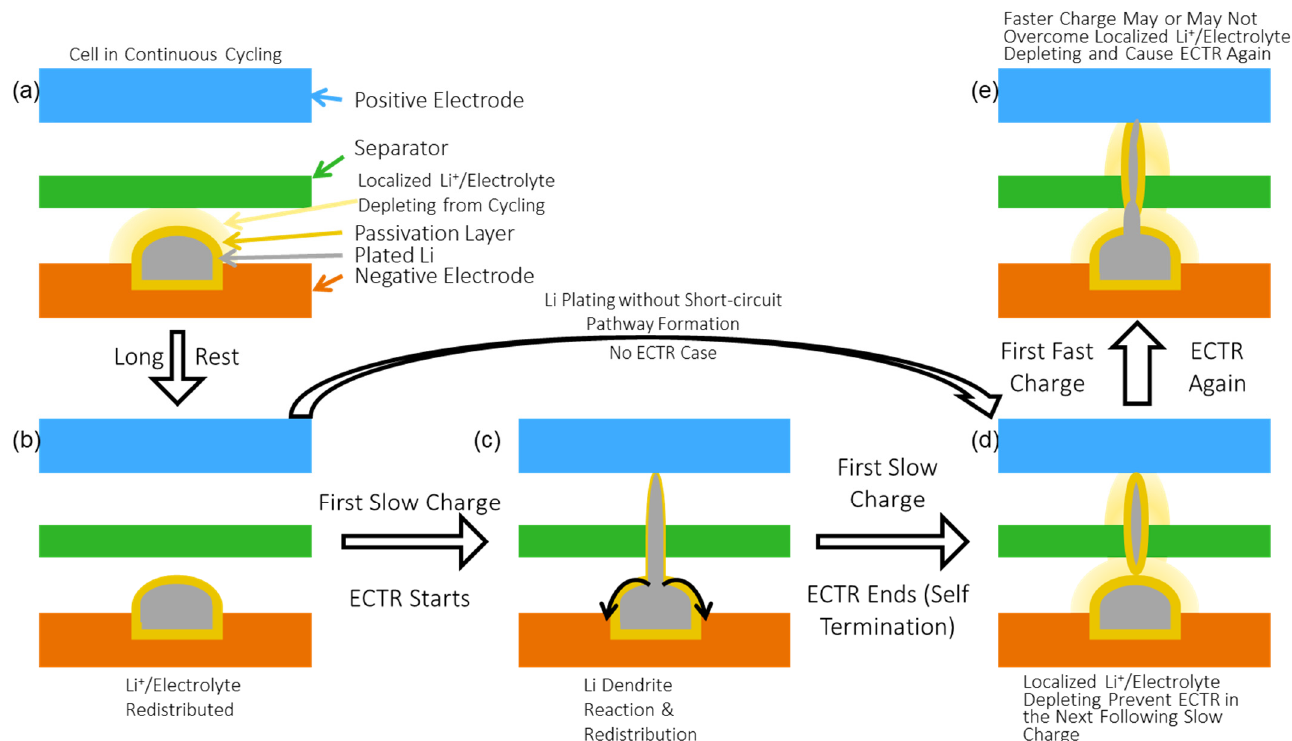
Figure 9. The scheme of a self-terminating short circuit caused by a lithium dendrite formed during charge. ( a ) The cross section of an aged cell after continuous cycling, with lithium plated on the negative electrode. The lithium metal is surrounded by a region of localized Li + and/or electrolyte due to the reaction between metallic lithium and the electrolyte. ( b ) After an extended rest, the localized depletion region around lithium metal is dissipated due to diffusion and relaxation. ( c ) The next low-rate charge causes a lithium dendrite to grow and penetrate the separator. When it reaches the positive electrode, a short circuit is formed resulting in a detectable ECTR event. The black arrows beside the dendrite indicating the lithium redistribution. ( d ) Ongoing reaction of the lithium dendrite with the electrolyte causes the dendrite to break, terminating the short circuit and leaving a dead lithium in the separator. This reaction continues even after the short is dissipated, forming a new depletion region around the lithium deposit, preventing retriggering of the short circuit. ( e ) If later charged at a high rate, the high current will lead to stronger driving forces for lithium dendrite formation, which causes the formation of a new short circuit and the retriggering of a second ECTR event.